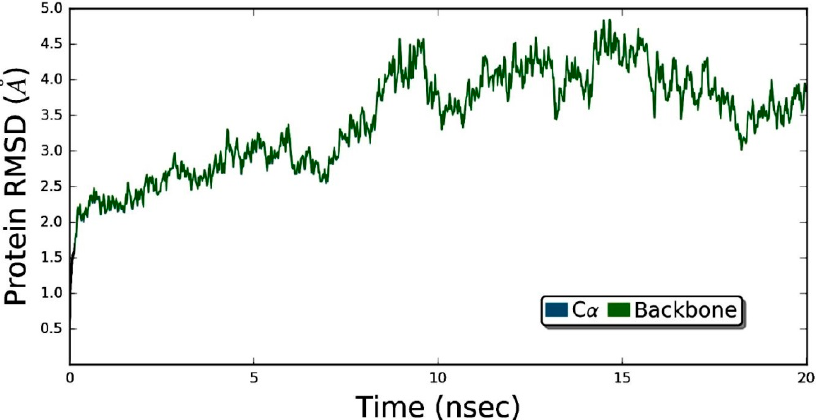
Figure 8. The root mean square deviation (RMSD) values for protein are shown on the y-axis during the simulation time of 20 nsec for ZER-integrin α v β 3 protein complex in the presence of TP5-iRGD peptide.